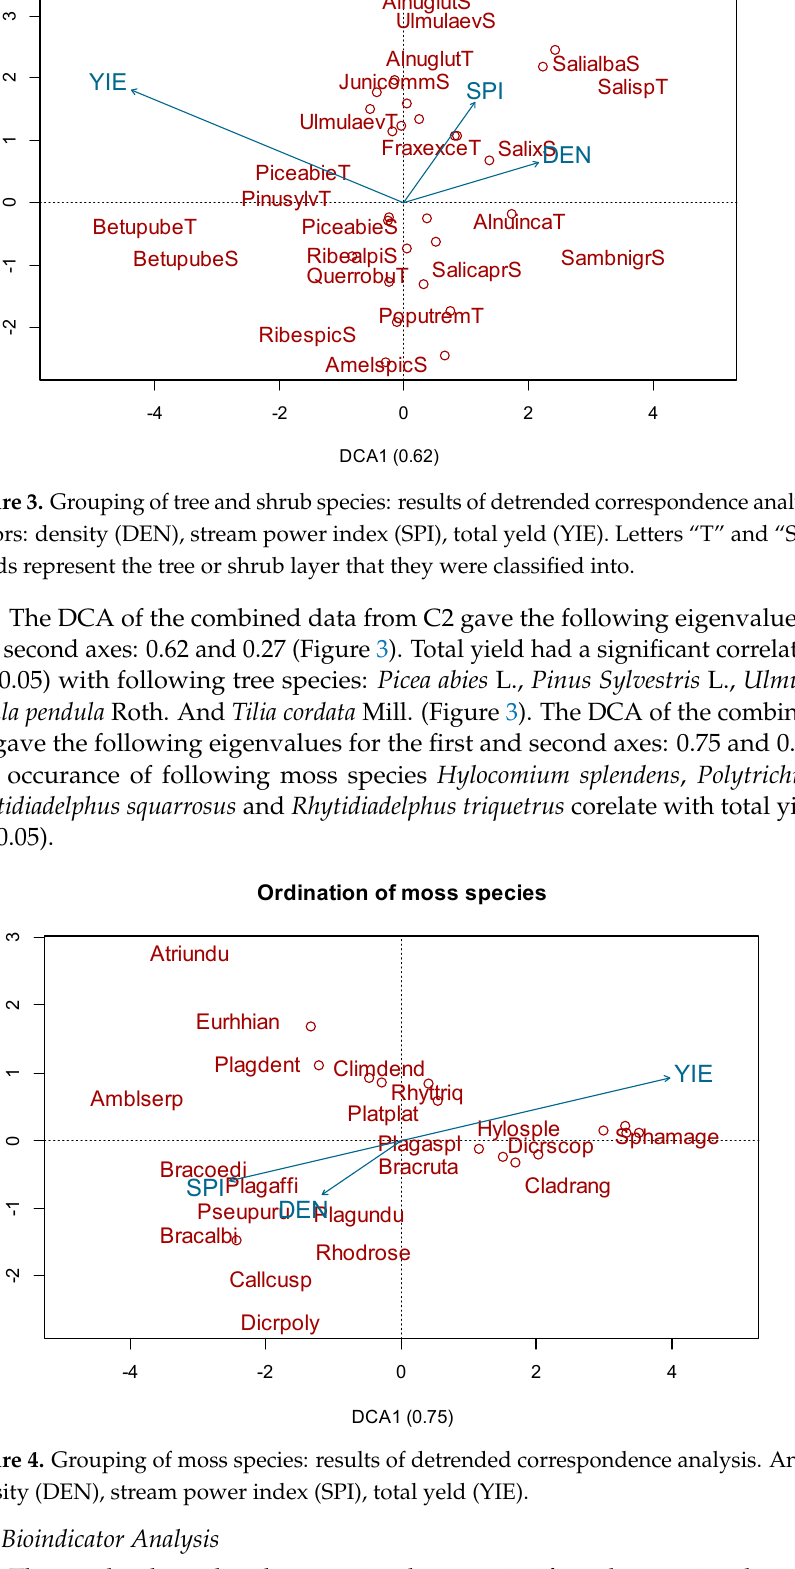
Figure 2. Grouping of understory vegetation species: results of detrended correspondence analysis. Analyzed factors: density (DEN), stream power index (SPI), total yeld (YIE). Letters “T” and “S” at the end of words represent the tree or shrub layer that they were classified into.